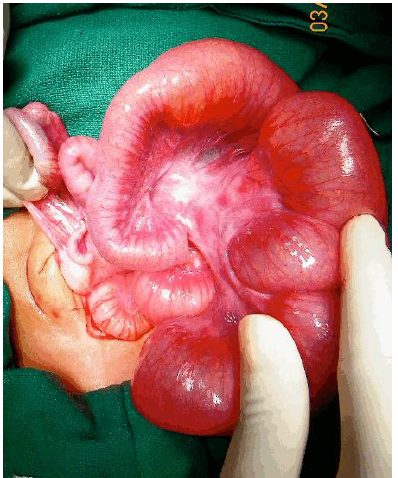
Figure 2: Intra-operative picture showing transition zone of aganglionosis in terminal